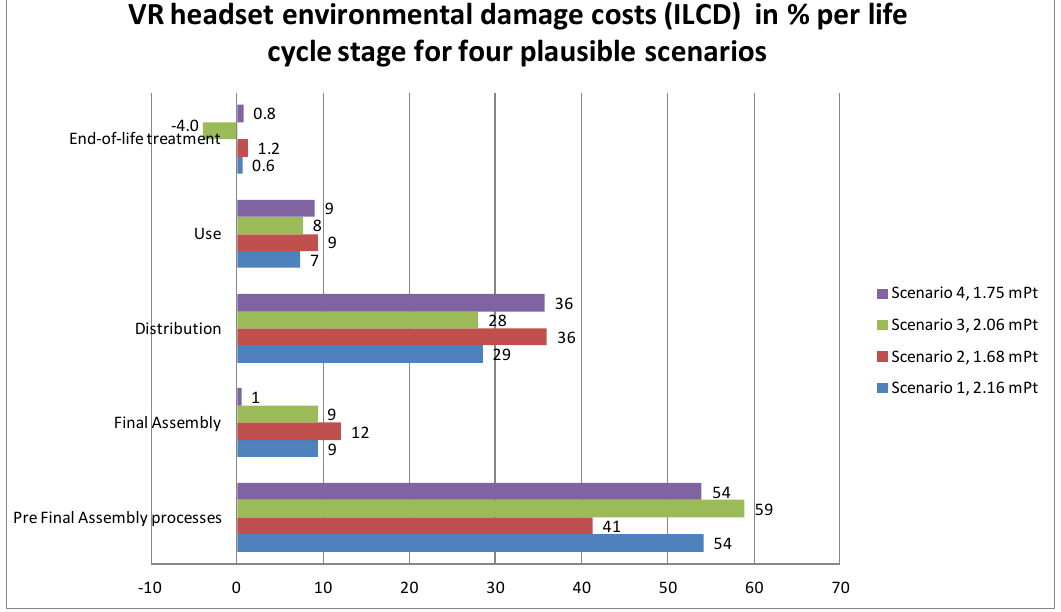
Figure 2. Screening Life Cycle Assessment (LCA) results (ILCD) for the VR headset for Scenarios 1–4.